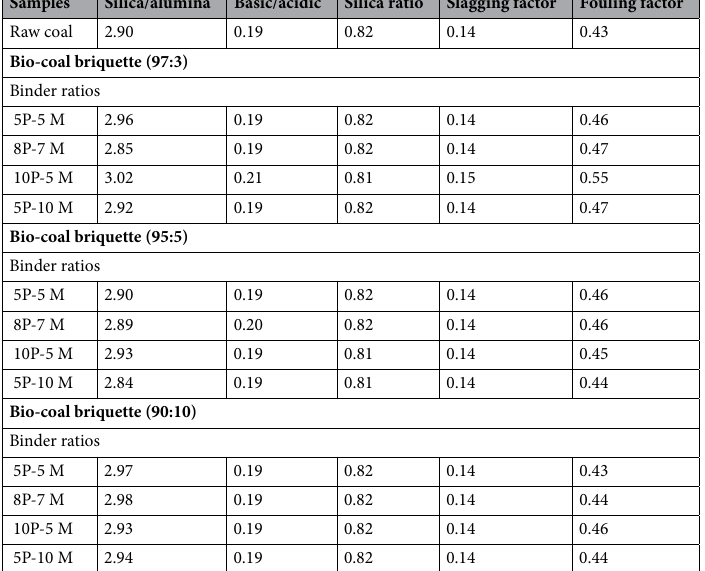
Table 4. Oxide ratios of the raw coal and bio-coal